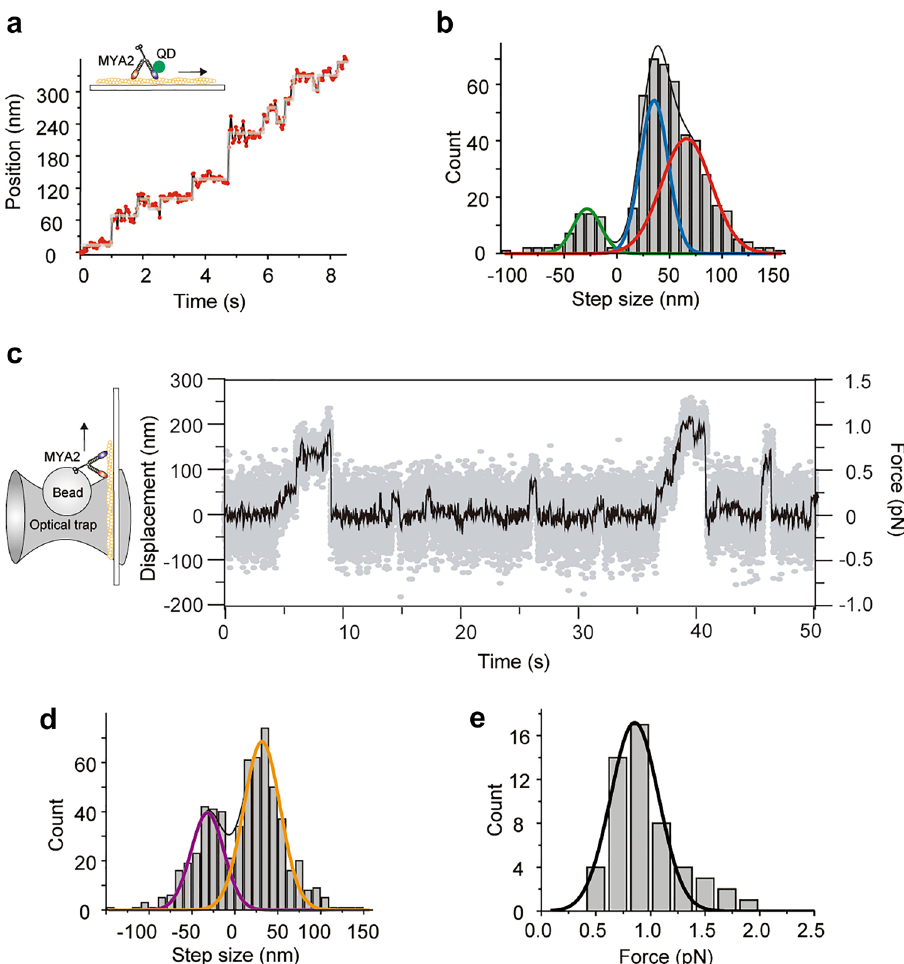
Figure 4. Stepping dynamics and force measurement of MYA2. ( a ) QD attached to a motor domain in a MYA2 dimer was observed using TIRFM at 2 nm and 33 ms spatiotemporal resolution. Steps were analyzed by an automated step-finding algorithm 43 (gray line). ATP concentration, 1 µM. ( b ) Step size histogram of the motor domain. The histogram fit to three Gaussian functions with peaks at 60.5 ± 14.8 nm (red line), 29.3 ± 6.9 nm (blue line), and − 28.1 ± 9.9 nm (green line), respectively. Black line indicates the convolution of three Gaussian functions. ( c ) Typical trace of optical trapping nanometry at 1 µM ATP. Gray line: raw trace; Black line: data passed through a 200 Hz low pass filter. ( d ) Step size histogram of an optically trapped bead attached to the MYA2 C-terminal tail. The histogram was fit to two Gaussian functions with peaks at 31.6 ± 15.2 nm (orange line), and − 31.9 ± 13.6 nm (purple line), respectively. Black line indicates the convolution of the two Gaussian functions. ( e ) Histogram of MYA2 stall force. The histogram was fitted to single Gaussian function with peaks at 0.85 ± 0.16 pN (black